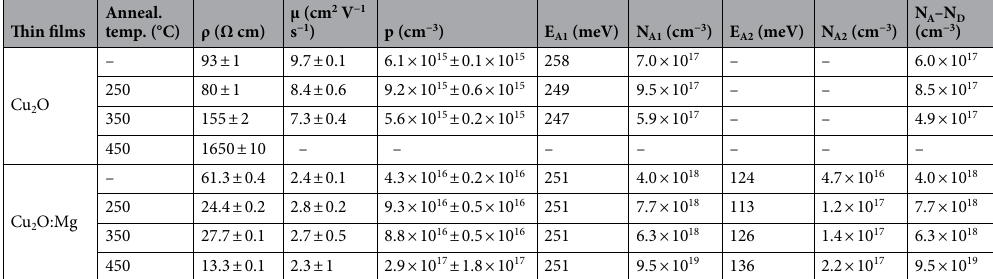
Table 1. Electrical transport properties of Cu 2 O and Cu 2 O:Mg (5%) films, as-deposited and thermally annealed in air at 250 °C, 350 °C and 450 °C. Resistivity, mobility and charge carrier density values were determined at room temperature by Hall effect measurements. Ionization energies and concentrations of the two acceptor levels, as well as the difference between acceptor and donor concentrations are obtained from the fitting of temperature-dependent Hall carrier density.